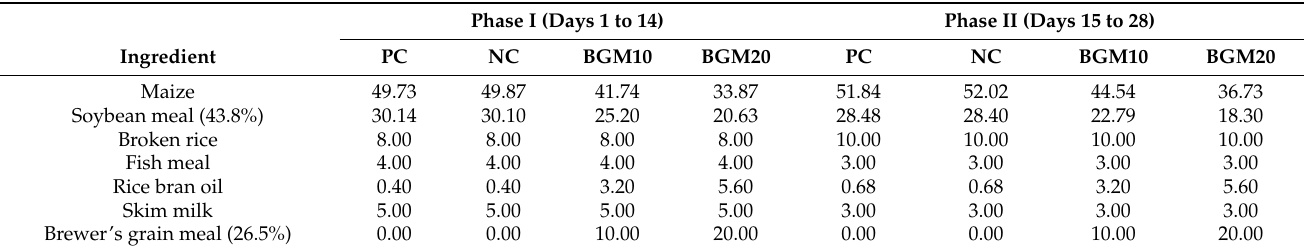
Table 1. Ingredients and composition values of the basal diets (% as-fed